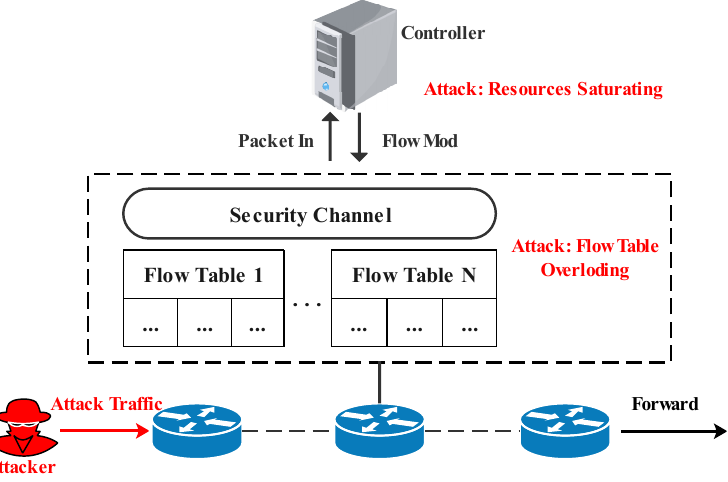
Figure 1. An example of a DoS attack